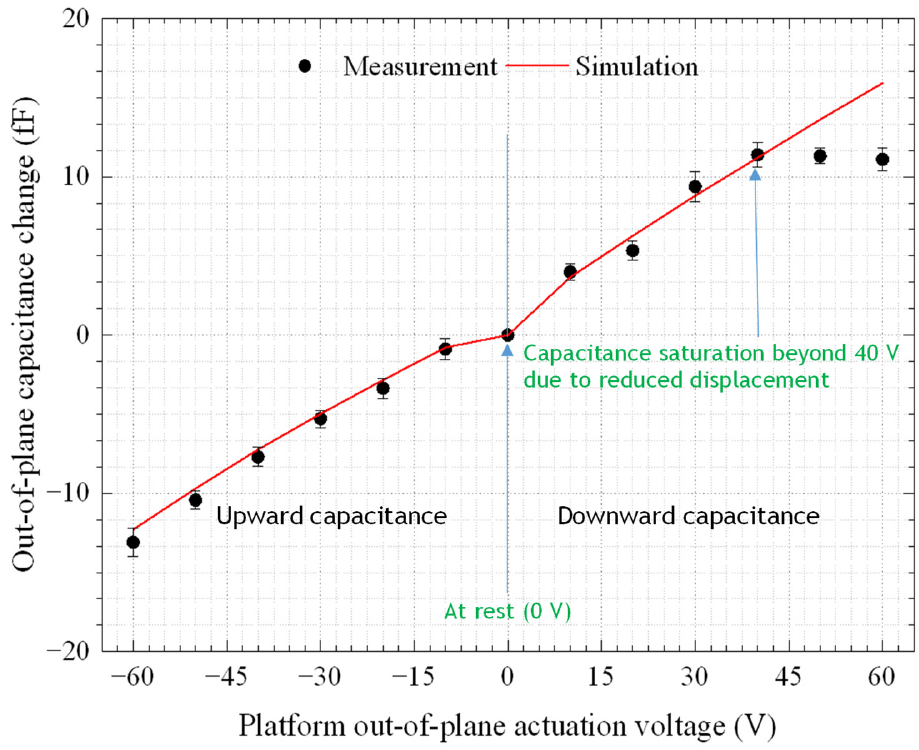
Figure 9. The average DC capacitance change versus the actuation voltage measured over five runs and the simulation results.